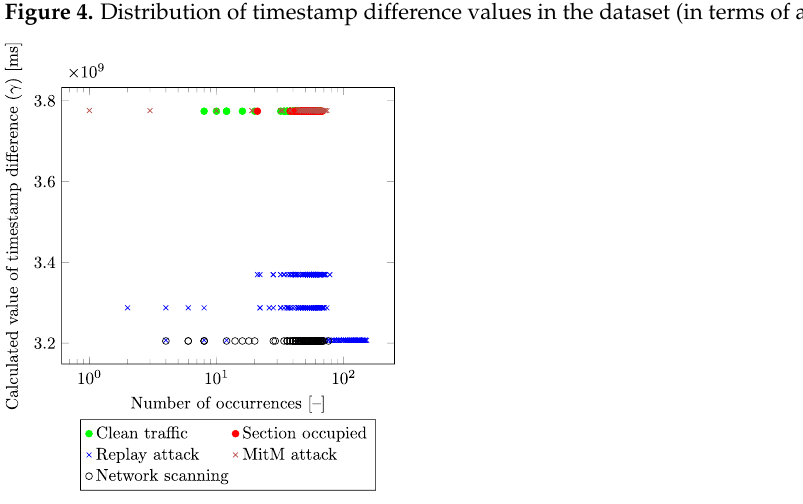
Figure 5. Distribution of timestamp difference values in the dataset (without DoS